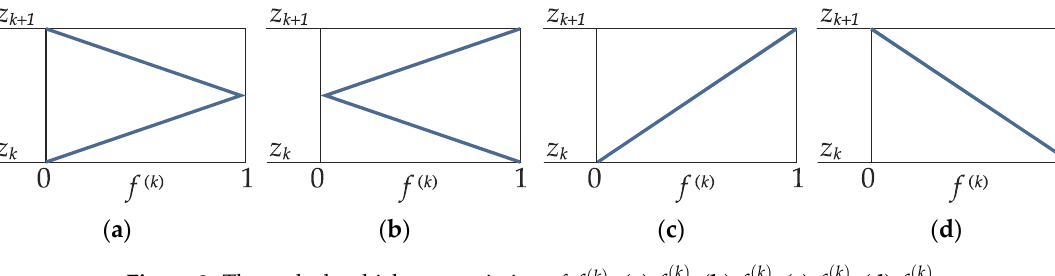
Figure 2. Through-the-thickness variation of f ( k ) : ( a ) f